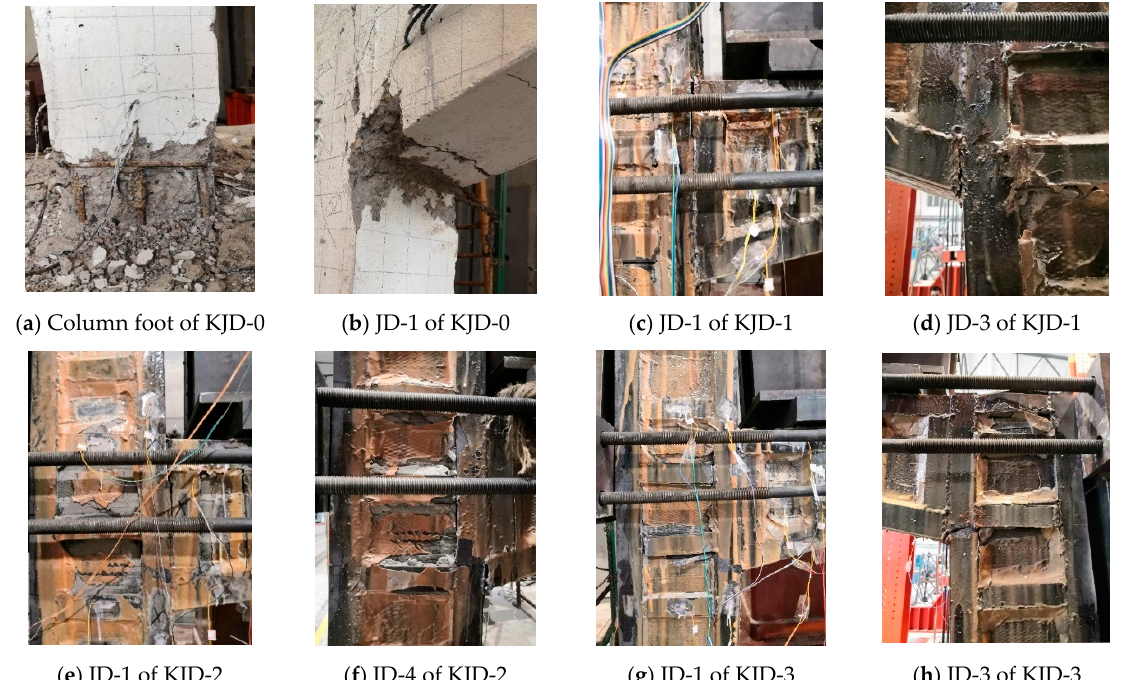
Figure 8. Typical failure phenomenon of